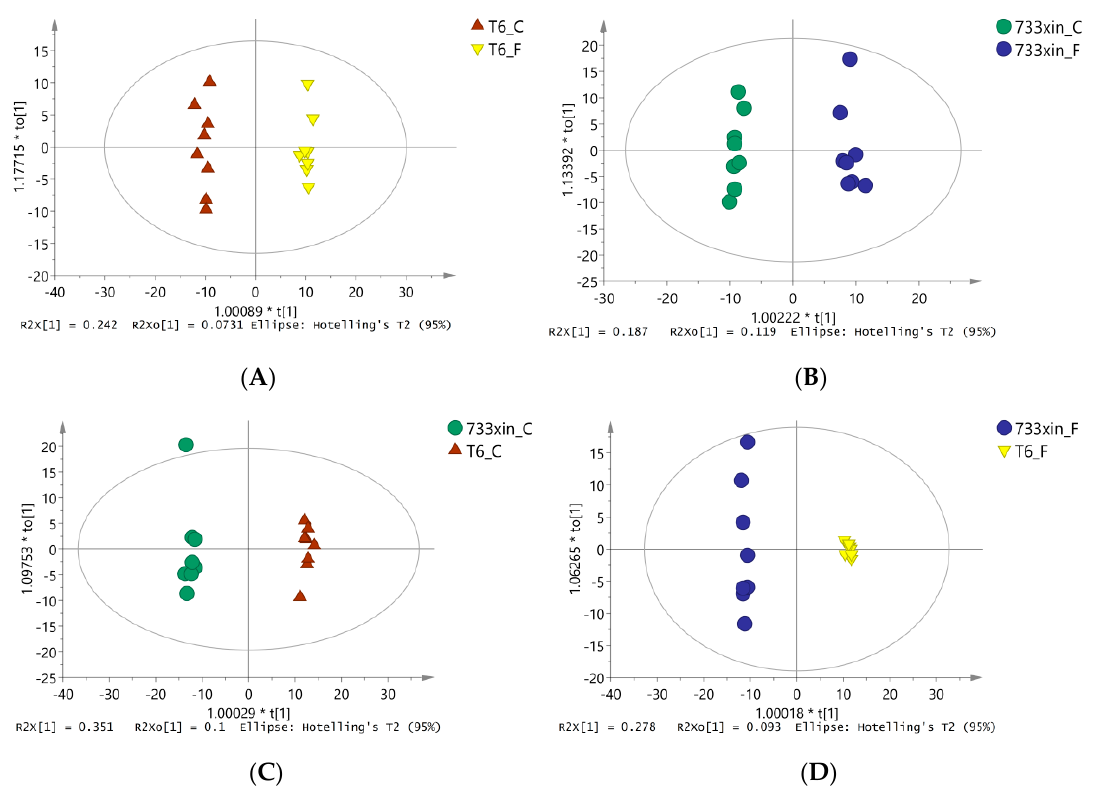
Figure 2. OPLS-DA model diagram. ( A ) OPLS-DA model diagram of T6_F-T6_C; ( B ) OPLS-DA model diagram of 733xin_F-733xin_C; ( C ) OPLS-DA model diagram of T6_C-733xin_C; ( D ) OPLS-DA model diagram of T6_F-733xin_F.Model parameter R 2 Y (the parameter value of this model does not refer to R 2 X value) represents the ability to interpret the model, and Q 2 represents the ability to predict the model. Table 1. Common di ff erential metabolites in four control